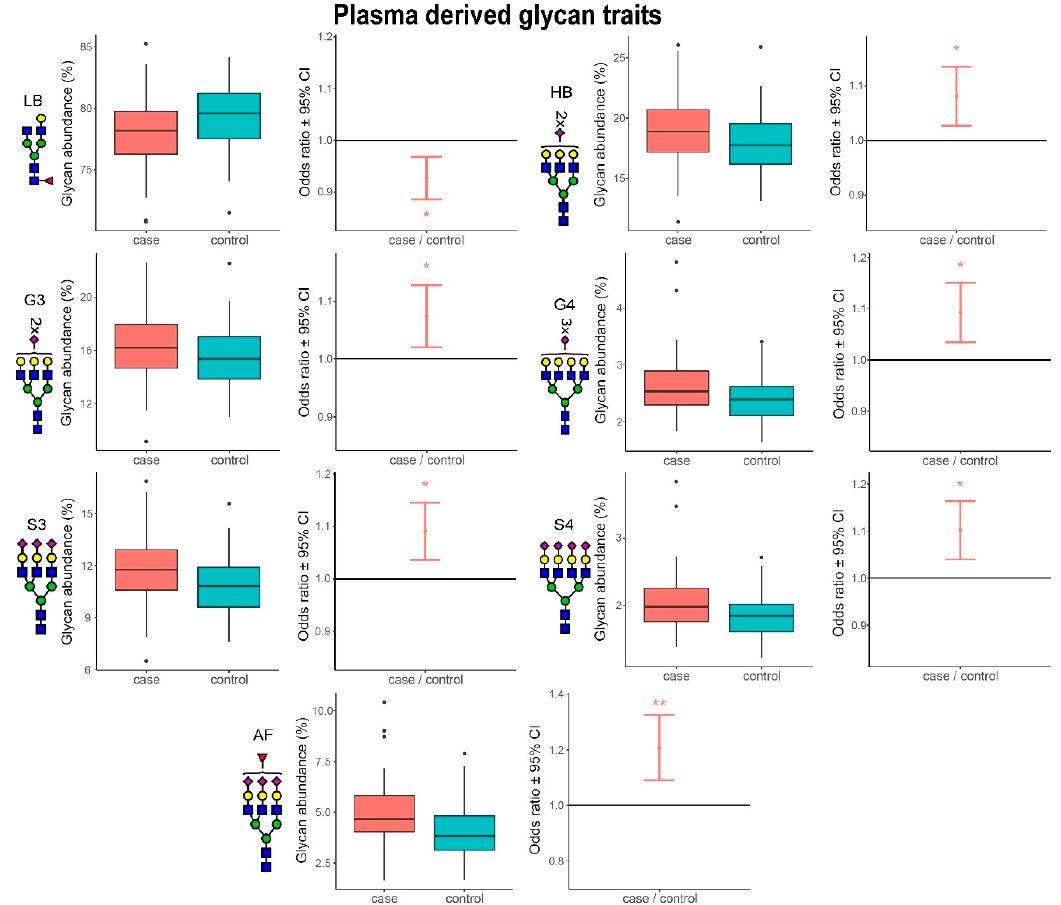
Figure 3. Most prominent differences between MS subjects and matched controls in plasma protein derived glycan traits. The left part of the figure shows boxplots representing differences in glycan abundances, while the right part shows odds ratio plots, resulting from post-hoc tests. Boxes in the boxplot are ranging from 25th to 75th percentile, with the median represented as a line inside the box. The whiskers of the boxplot extend from both percentiles, 75th percentile for upper whisker and 25th for lower whisker, to the values within 1.5 × IQR. IQR is the inter-quartile range, also known as the distance from the first to the third quartile. Data outside the whiskers’ ends are outliers, represented with black dots, and are plotted individually. On the odds ratio plots, middle dot represents odds ratio value for represented derived glycan trait surrounded by its 95% confidence interval (CI). Odds ratio of 1.0 means that there is no difference between compared groups for the given trait. Asterisk symbols represent statistical significance: * < 0.05; ** < 0.01.